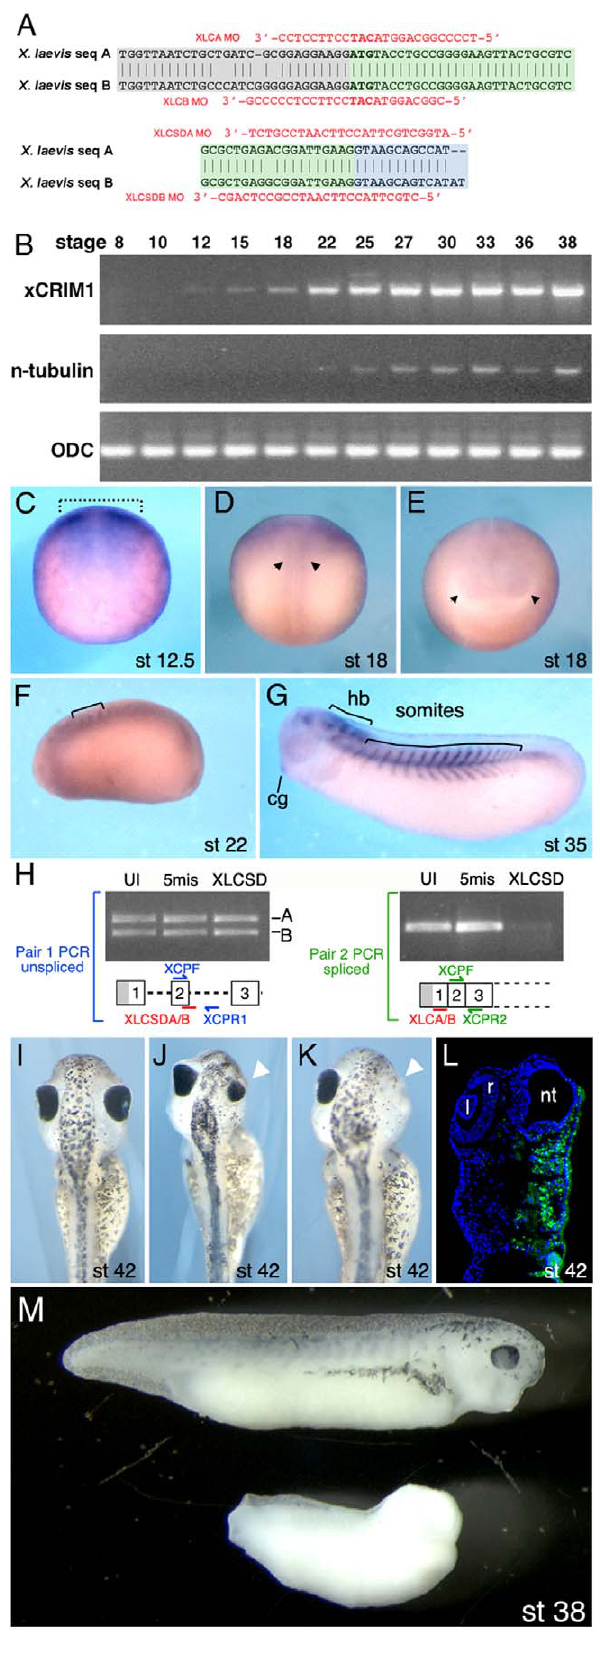
Nucleotides complementary to the start codon of CRIM1 are indicated in bold. Control Morpholinos have either a 5 nucleotide mismatch (5 M) or are the standard control Morpholino (SCMO) from GeneTools. Mismatched nucleotides are indicated in lower case.